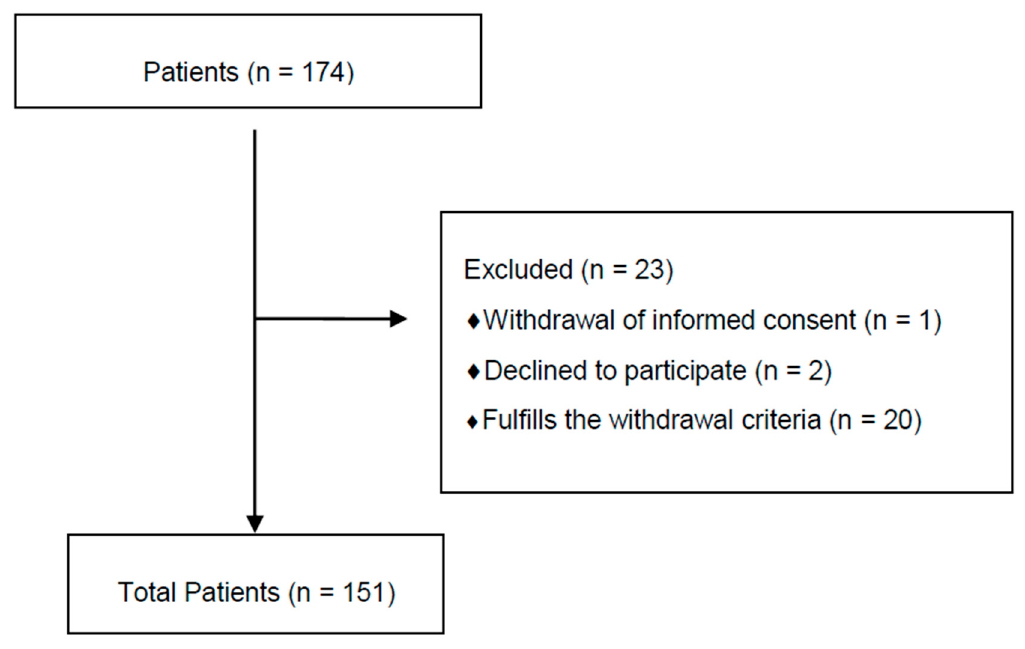
Figure 1. Flow chart of participants.